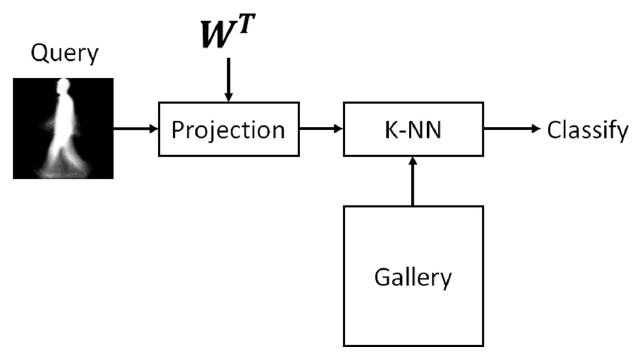
Figure 8. Classification